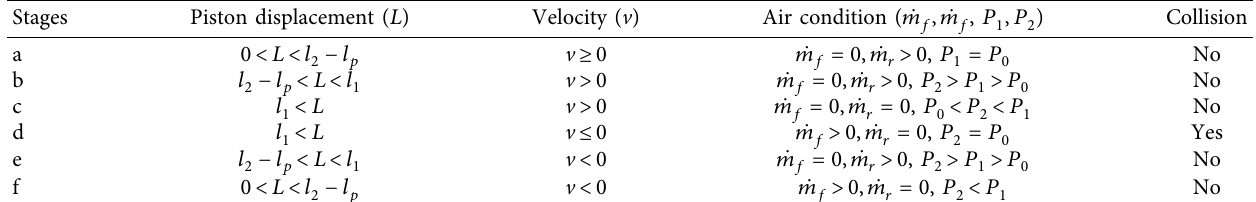
Figure 2: Working principle of the pneumatic hammer. (a), (b), and (c) represent the stroke phase; and (d), (e), and (f) represent the backhaul phase. Table 1: Piston logic and conditions at each